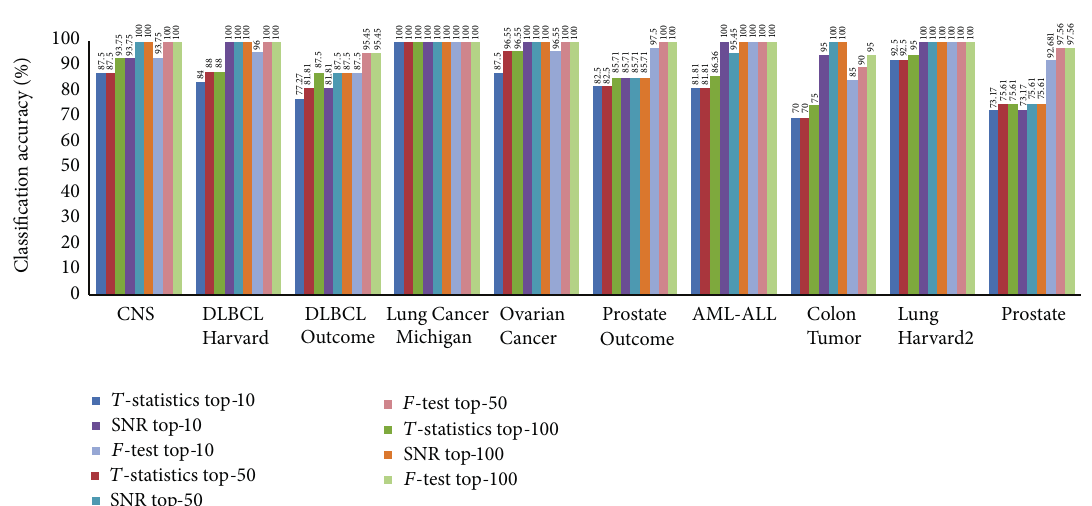
Figure 6: Classification accuracy using shuffled frog leaping with L´evy